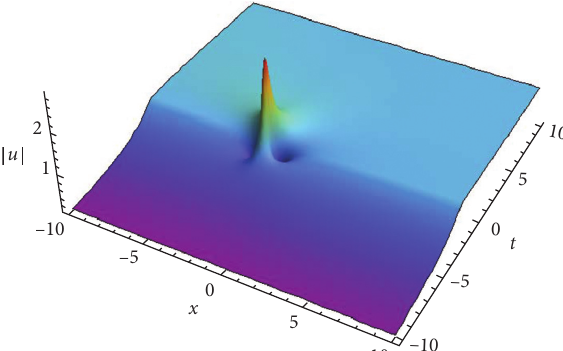
Figure 11: Asymmetric first-order fractional rogue wave (color online) with α � 9/10 and a � − 2 modified from solution